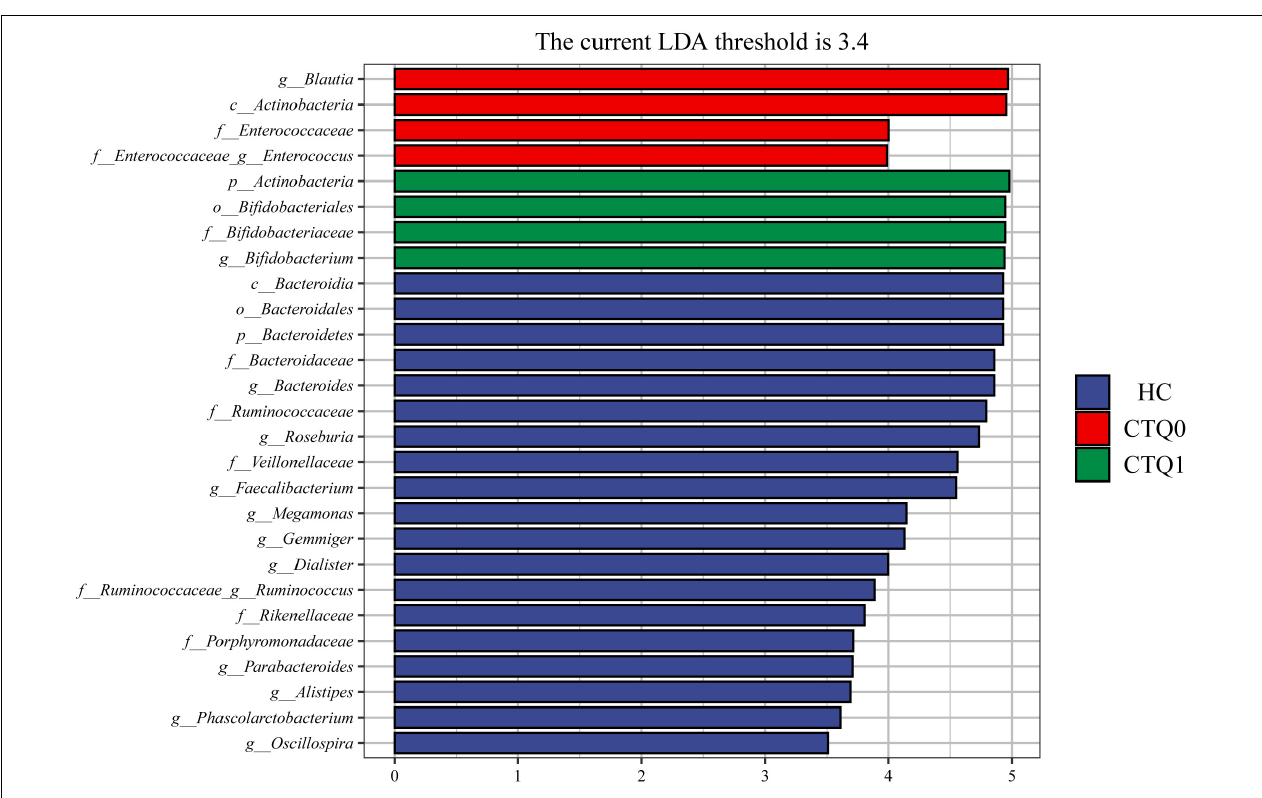
FIGURE 3 | Taxonomic biomarkers found by LefSe analysis in HCs, the CTQ0 group and the CTQ1 group (marked by blue, red, and green color, respectively; the levels of phylum, class, order, family, and genus were indicated with p, c, o, f, and g, respectively, before the name of each microorganism. Only taxa with a P < 0.05 and an LDA score over 3.4 is